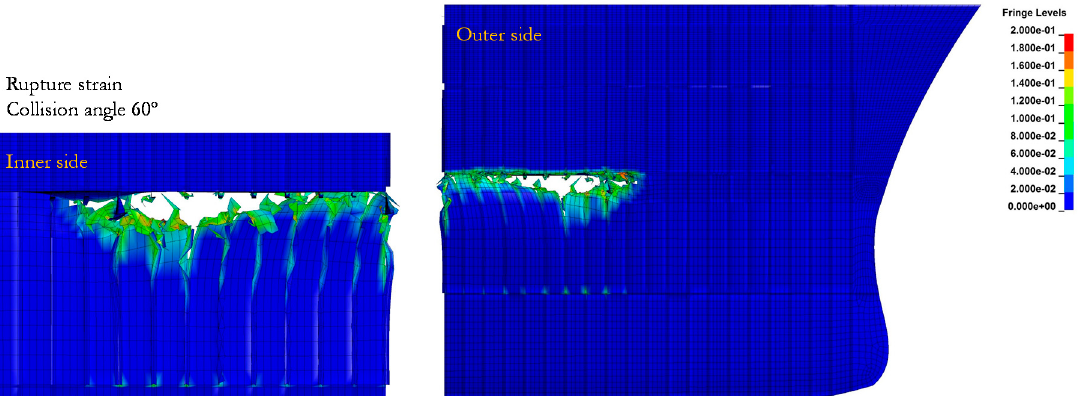
J. Mar. Sci. Eng. 2019 , 7 , x Figure 10. Contours of the strain near the car deck: Angle 60 ◦ . Figure 10. Contours of the strain near the car deck: Angle 60°.